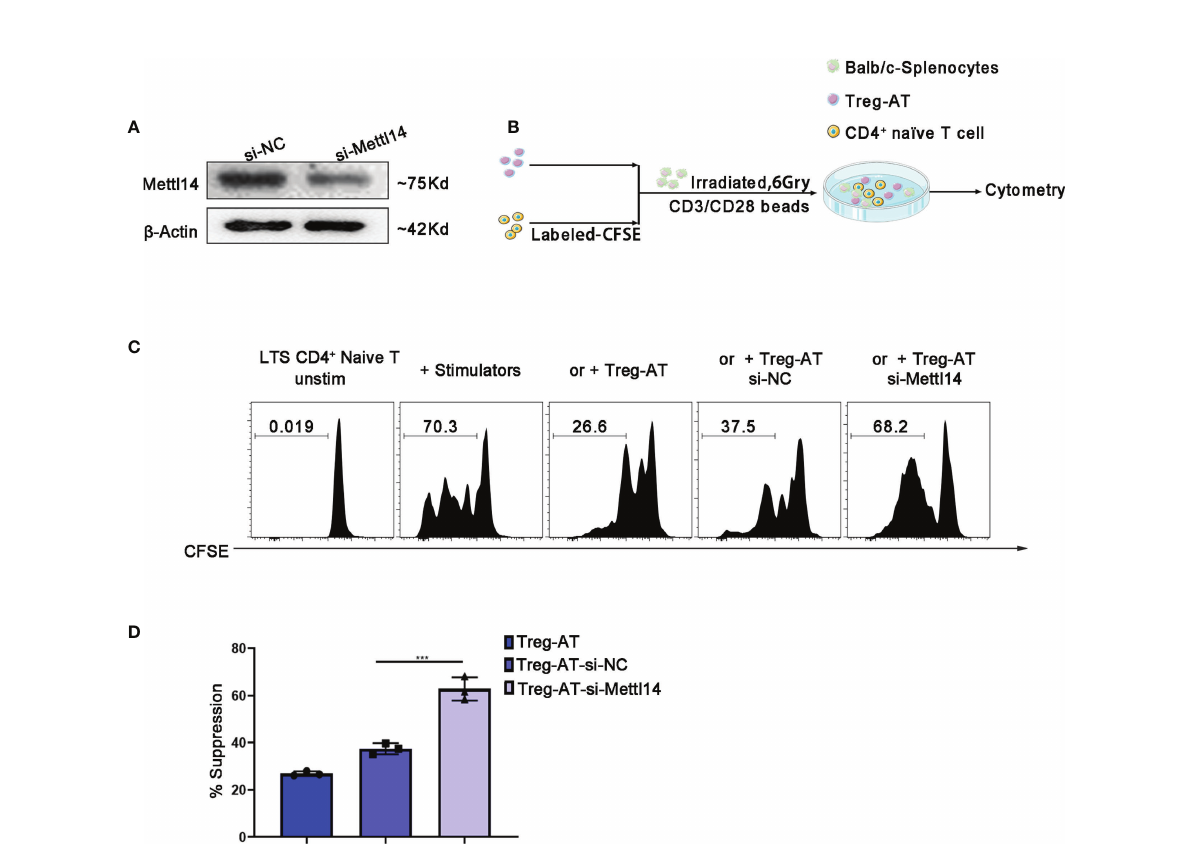
FIGURE 5 ManipulationoffunctionalTregcellsby disturbingMETTL14expression invitro. (A) Tregcellsisolatedfromthegroupofallograft tolerance(Treg-AT),and transfectedwithsi-negativecontrol(Treg-AT-si-NC)orsi-Mettl14(Treg-AT-si-Mettl14).METTL14 expressionwasdetectedusingwesternblot. (B) The experimentalplan forthemixedlymphocyteresponseassay. Inbrie fl y,theCD4 + naïveT-cells(0.3×10 6 )servingasresponderswereisolatedfromthe spleenandlabeledwithCFSE. TheBALB/csplenocytes(2×10 5 )wereirradiated(6Gry)andservedasallogeneicstimulatorcells. Ingeneral,the responder cellsandstimulatorcellswereresuspended in96-well round-bottomplates,andT-activatorCD3/CD28Dynabeads(0.5 m g/ml)were added. Subsequently, theTreg-AT, Treg-AT-si-NCorTreg-AT-si-Mettl14 (0.2×10 4 )was addedtoeachwell. Thesecellswere cultured at37°Cfor5 days, andproliferationwas monitoredusing fl owcytometry. (C) Mixedlymphocyteresponse assayswereperformedtodeterminethe suppressivefunctionandstabilityofTregcellsin theallografttolerancegroup. CFSE-labeledCD4 + naïveTcellsasrespondercells, andwerestimulatedwithBALB/csplenocytes,andthe Treg-AT, Treg- AT-si-NC,orTreg-AT-si-Mettl14wereusedassuppressorcellsinthisassay.The ratioof proliferationCD4 + naïveTcellsinthe presenceofTreg-AT, Treg- AT-si-NC,orTreg-AT-si-Mettl14wasdetectedusing fl owcytometry. Thedataarepresentedasthemeans±SD. Thedata (D) arerepresentative of three independentexperiments.The statistical analysiswas performedwithanunpairedStudent ’